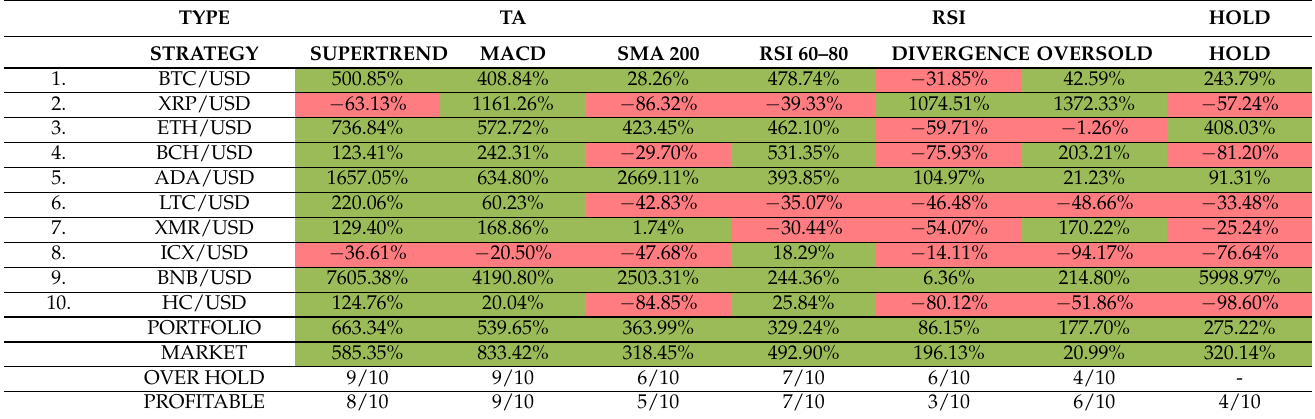
Table 8. The results of strategies from experiments compared to popular trading strategies between 2018 and 2022. Green indicates positive results, red indicates negative